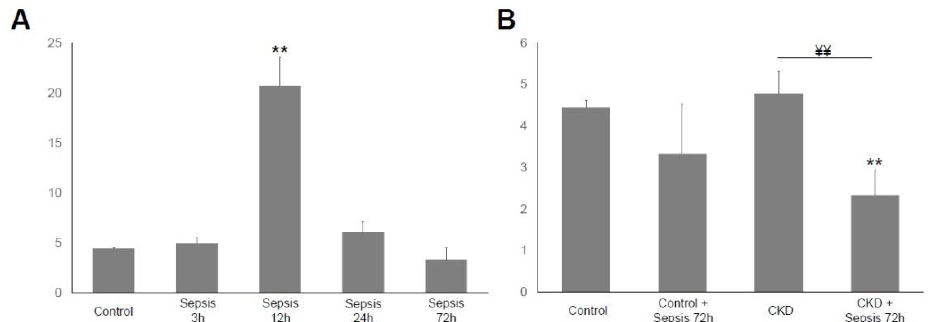
Figure 3. The trend in serum IL - 6 concentration level according to the course of sepsis: ( A ) in the control group, serum IL - 6 level peaked at 12 h of sepsis; ( B ) Serum IL - 6 level was significantly lower in the CKD + sepsis 72 h group than in the CKD group. IL - 6, interleukin - 6; Control, sham - operated model; sepsis model with 3, 12, 24, and 72 h after cecal ligation and punture (CLP); CKD, chronic kidney disease (5/6 nephrectomized) model. ** p < 0.01 vs. control, ¥¥ p < 0.01 vs. CKD.